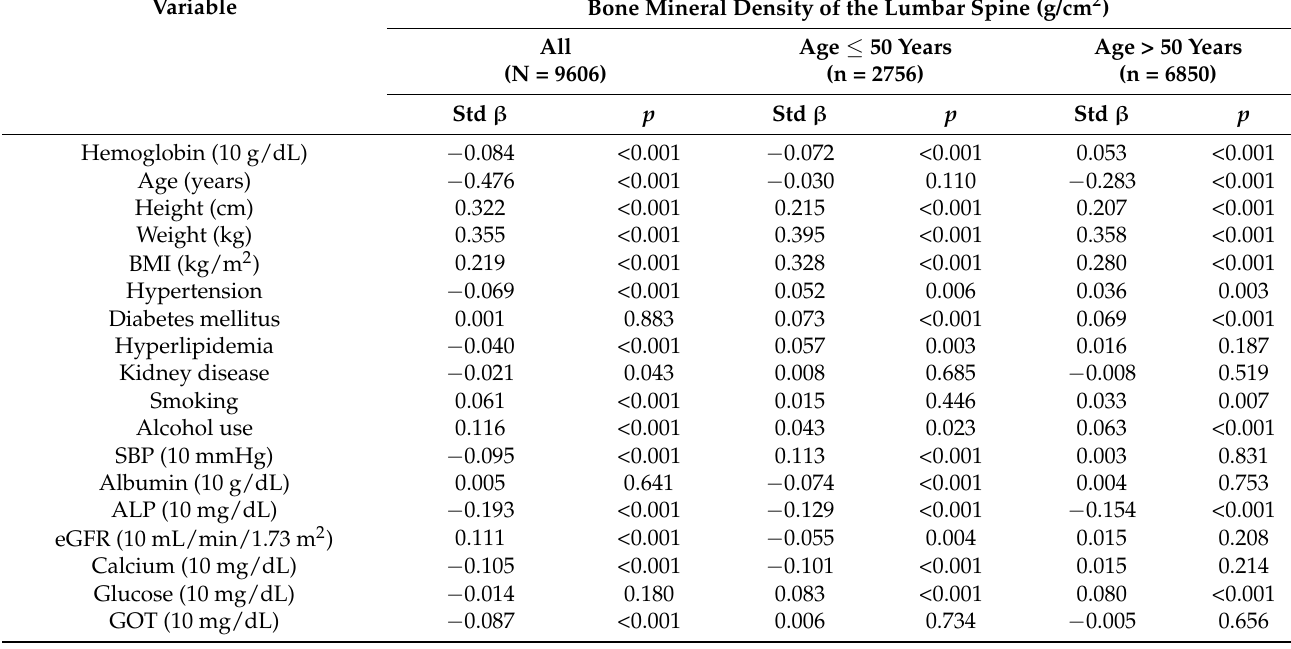
Table 3. Simple linear regression analysis of factors associated with bone mineral density of the lumbar spine in female patients with and without stratification by